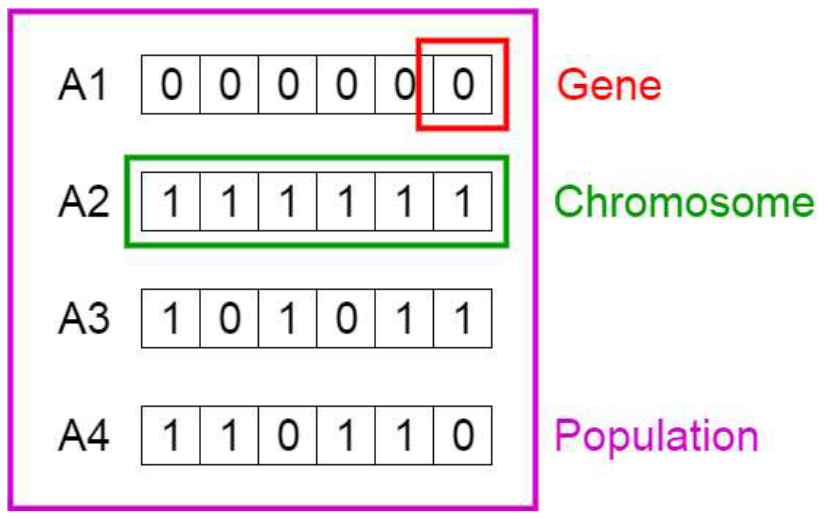
Figure 11. Distinction between population, chromosome, and gene.